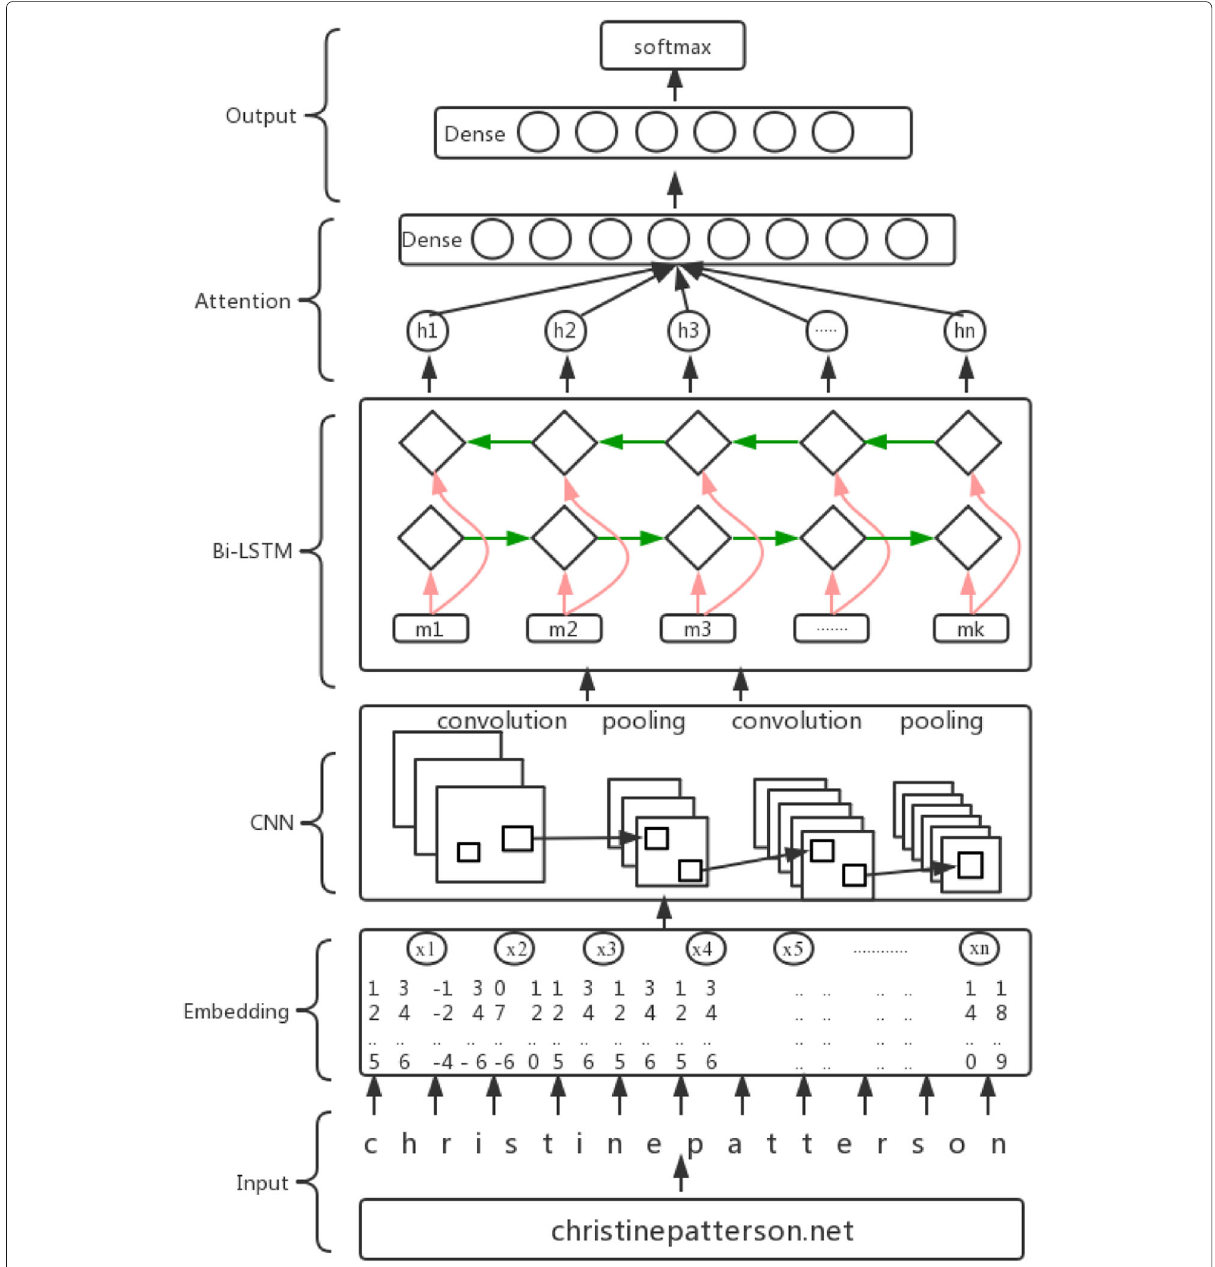
Fig. 1 The architecture of the ATT-CNN-BiLSTM model